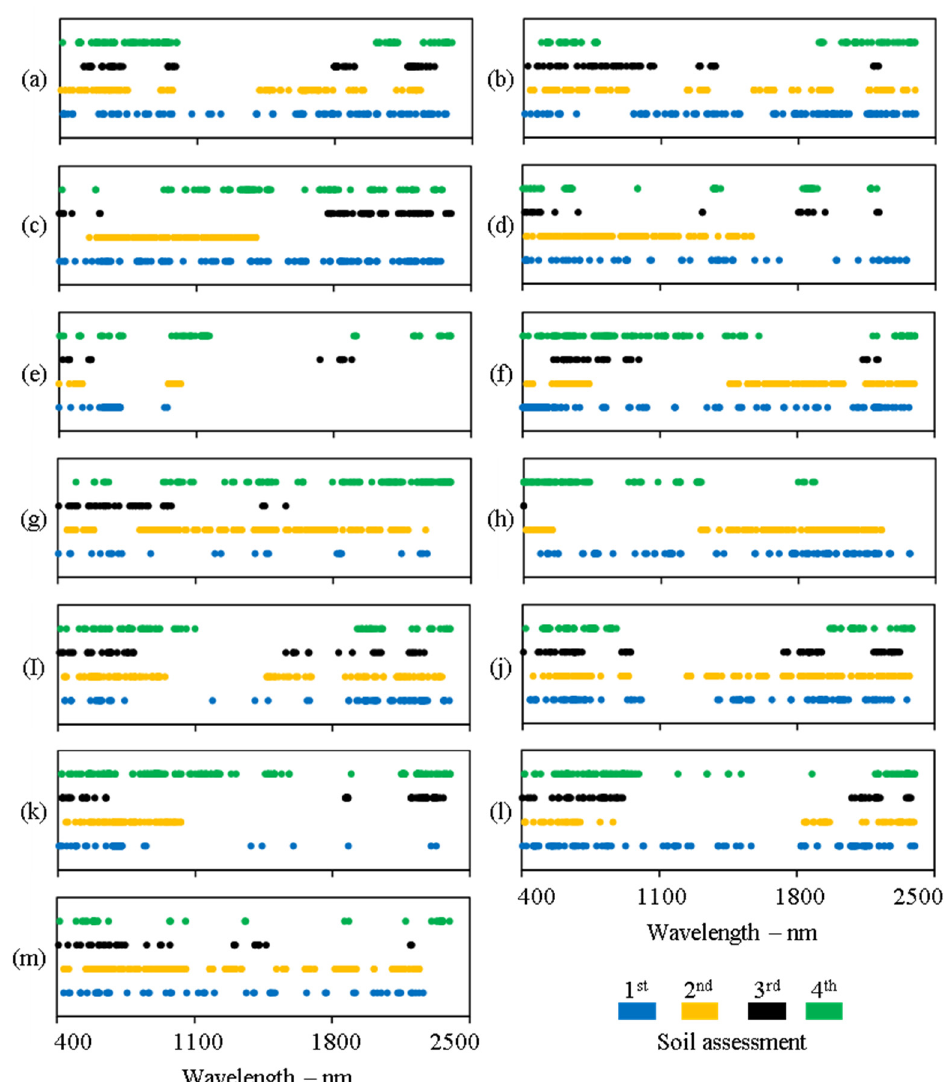
Figure 6. Wavelengths selected by the iPLS method for each variable in the four soil assessments: ( a ) Ca 2+ , ( b ) Mg 2+ , ( c ) K+, ( d ) P, ( e ) S-SO 4 − 2 , ( f ) pH, ( g ) Al 3+ , ( h ) H+Al, ( i ) SB, ( j ) CECe, ( k ) CEC, ( l ) m%, and ( m ) BS.